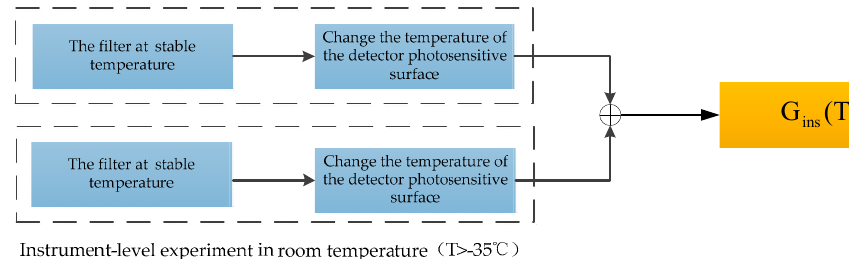
Figure 6. Schematic diagram of the instrument ‐ level RTDC experimental method.